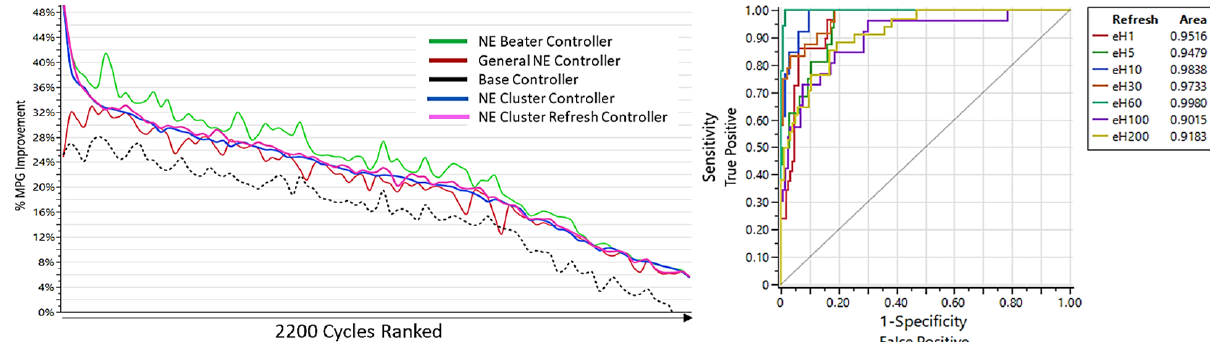
Figure 15. The Refresh option for the NE Cluster controller brings marginal benefits and requires a classifier to be used to pick the effective refresh rate. The refresh rates shown here range from 1 to 200 s intervals.